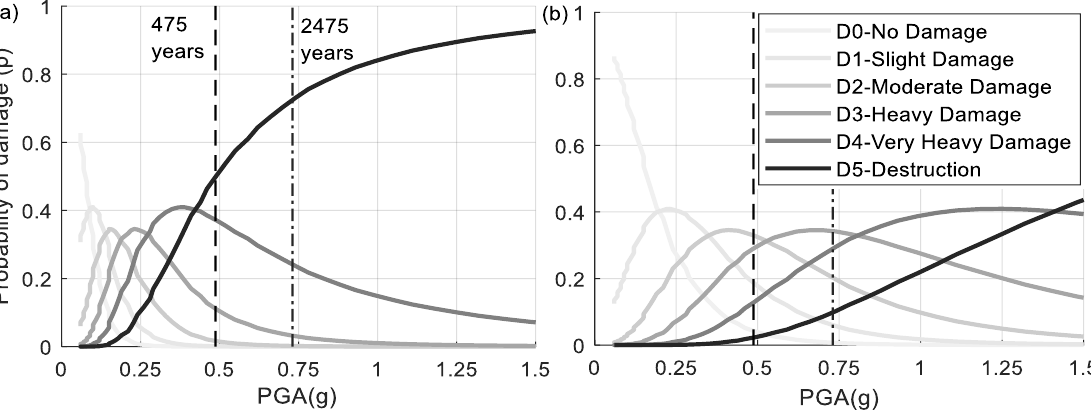
Figure 7. Density probabilities of the damage vs. PGA for ( a ) masonry with brick walls; and ( b ) reinforced concrete shear wall with low ductility.